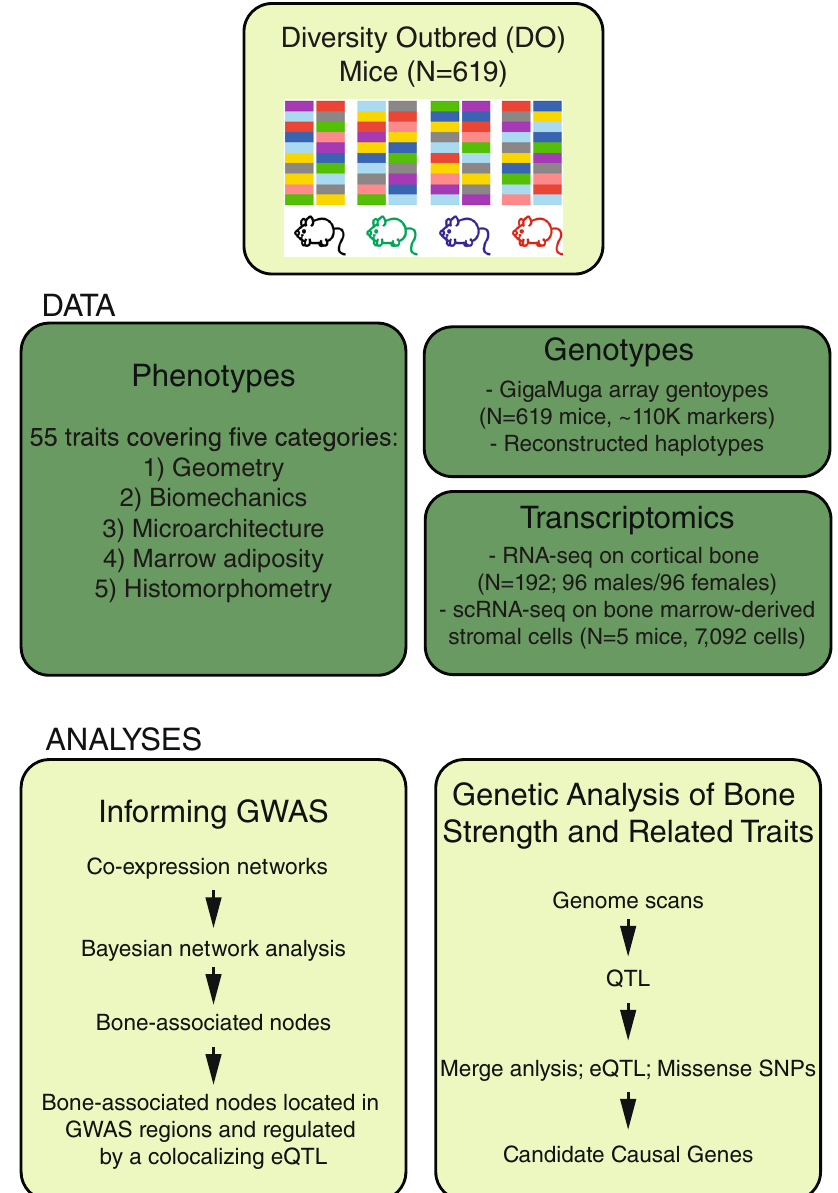
Fig. 1 Resource overview. An overview of the resource including data generated and analyses performed. GWAS genome-wide association study, QTL quantitative trait loci, eQTL expression quantitative trait loci, SNP single-nucleotide